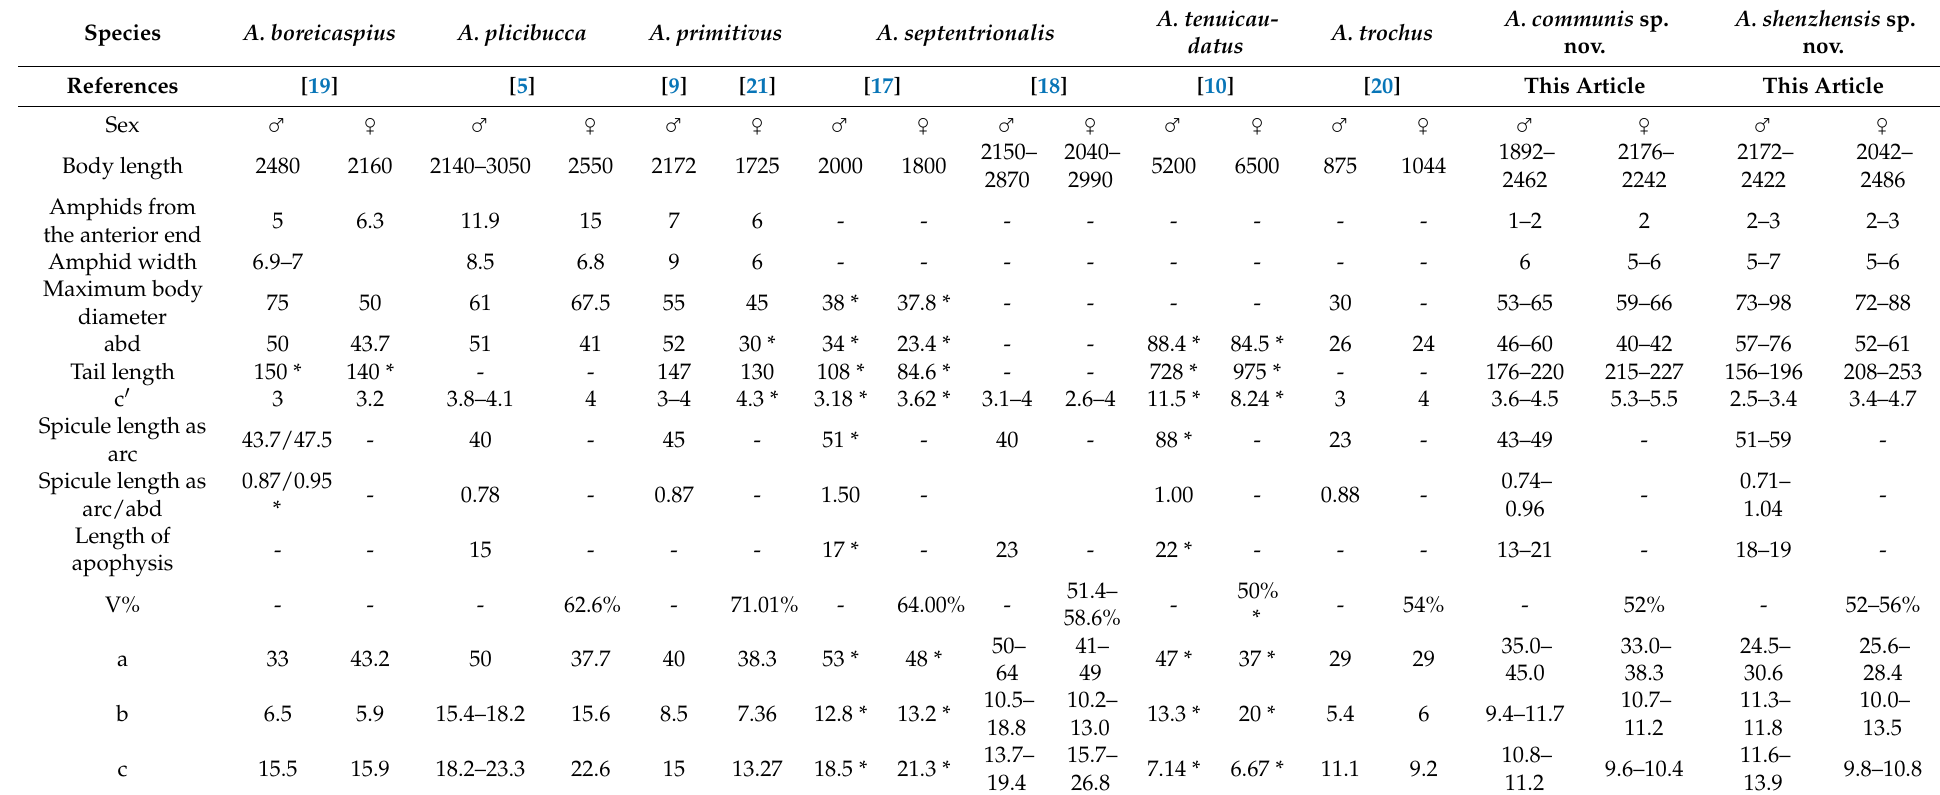
Table 4. Differentiating characters of all known Anticyathus species (in µ